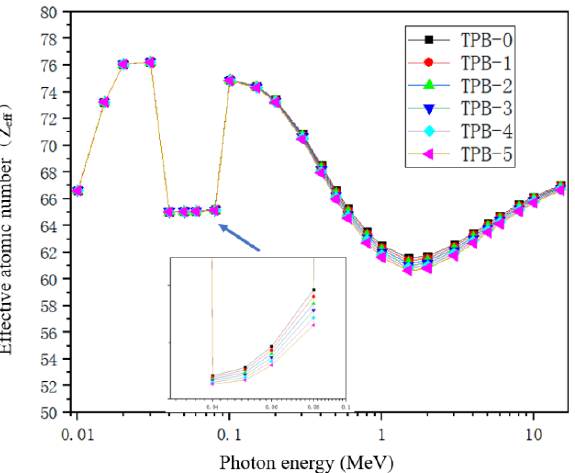
Figure 7. Effective atomic number (Z eff ) of TPB glass system for total electron interaction. Table 3. Mass attenuation coefficient μ m (cm 2 /g) of B element, Ba element and Pb